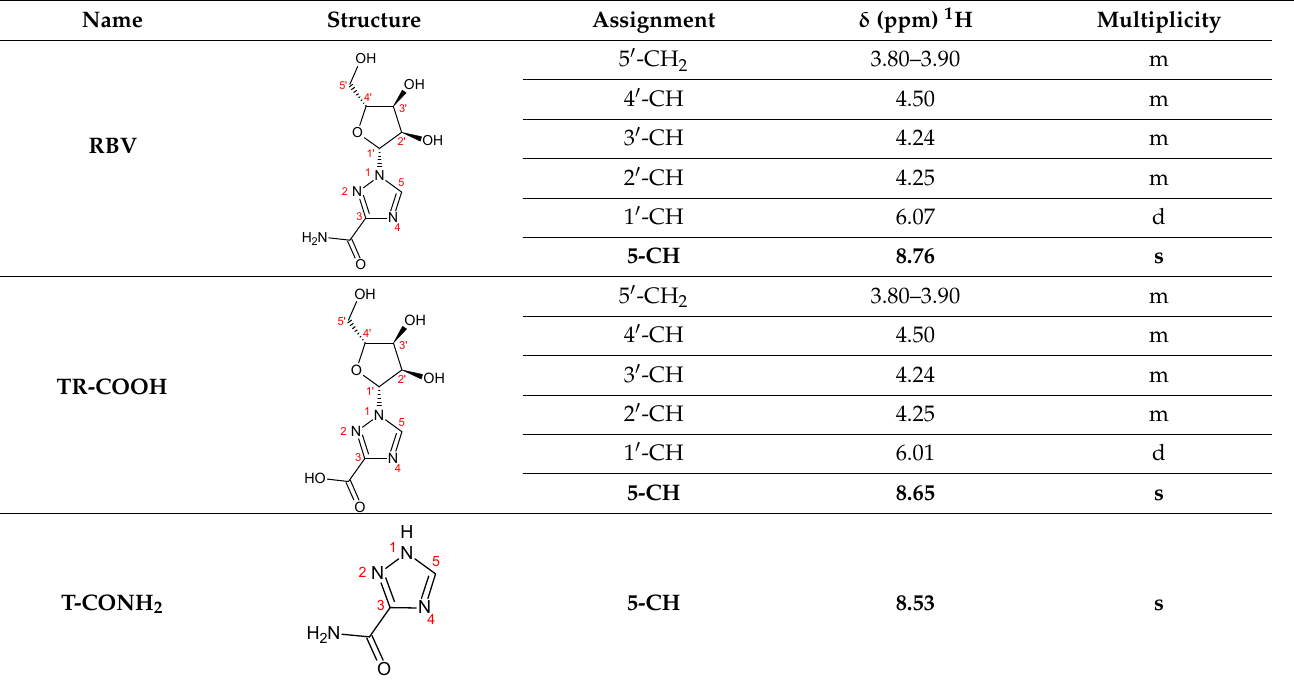
Figure 1. RBV and its metabolites. A: RBV; B: TR-COOH; C: T-CONH 2 ; D: T-COOH. In order to assess the assignment of RBV and its metabolites, two zones of the whole NMR spectrum have been taken into account: (1) Spectral region between 5.97 and 6.10 ppm (resonances of ribosyl moiety); (2) Aromatic region between 8.50 and 8.80 ppm (resonances of triazole moiety). The assignments of RBV and its metabolites in the urine samples of patients under therapy are shown in Table 1. Table 1. 1 H-NMR assignment of RBV and its metabolites in urine. The integrated resonances for quantitative analysis are reported in bold.